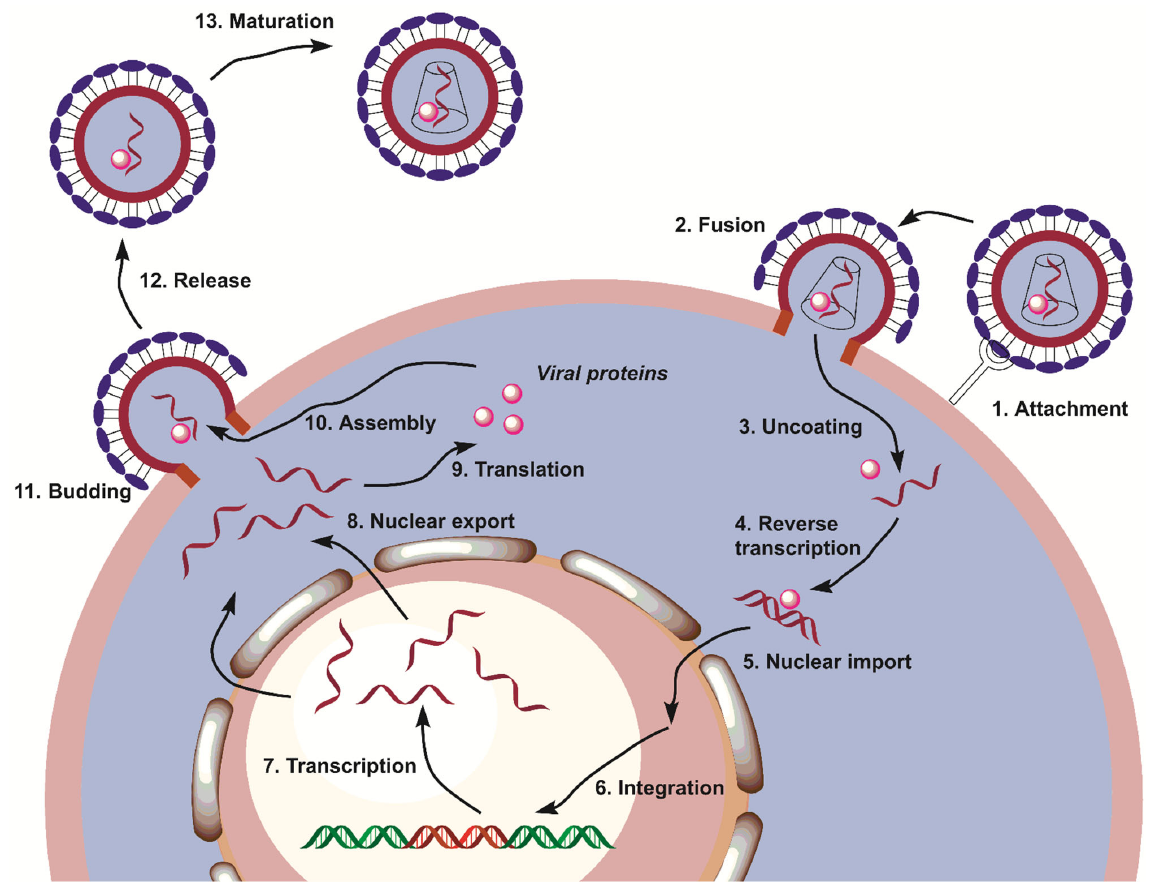
Figure 1. Steps of the HIV-1 replication